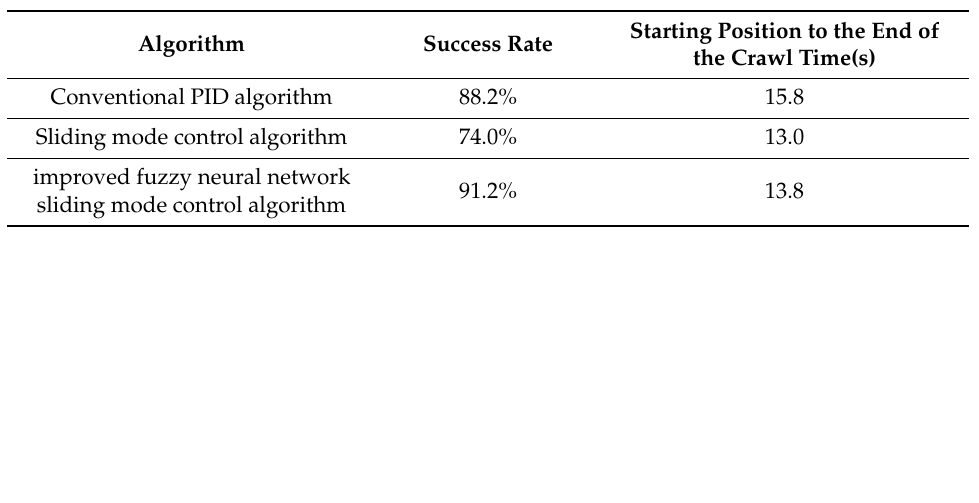
Figure 14. Angular velocity tracking of joints 1 and 2. Table 3. Experimental